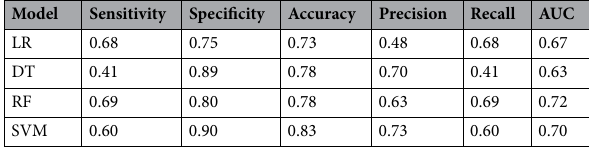
Table 2. Results of cross-validation for different machine learning algorithms using MMSE data.